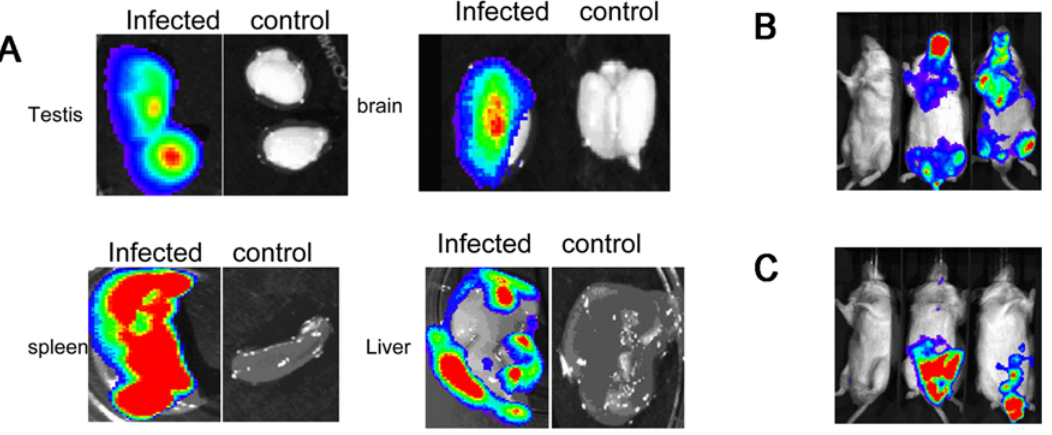
Figure 4. The light production in organs and after intraperitoneal (ip) and intravenous (iv) substrate inoculation. A. Imaging of bioluminescent parasites in organs from BALB/c mice infected i.p. with 2 6 10 4 T.b. brucei AnTat 1.1 and uninfected controls 20 days after infection. Coelenterazine was added to all organs before light detection ex vivo . B, C. Real time in vivo imaging of light producing T.b. brucei AnTat 1.1 in mice at day 20 after infection. Coelenterazine was inoculated i.v. (B) or i.p. (C) 2–4 minutes before light detection.